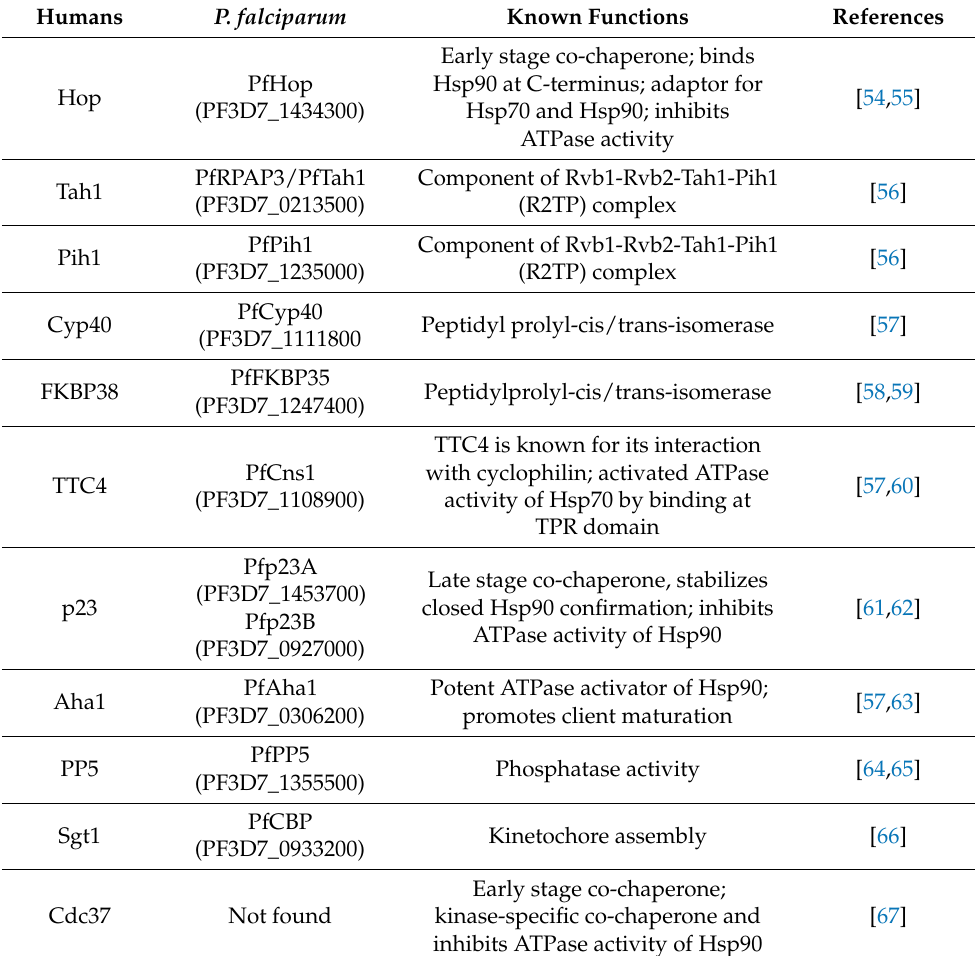
Table 1. Co-chaperones of Hsp90 in Homo sapiens and Plasmodium falciparum . Humans P.